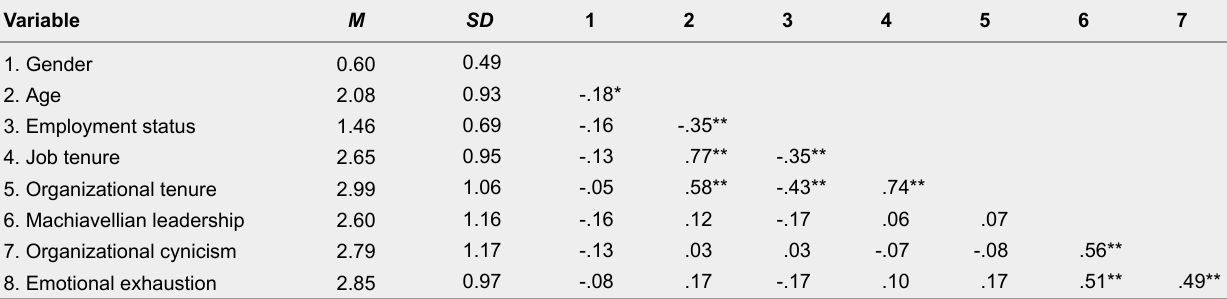
Descriptive Statistics and Correlations.